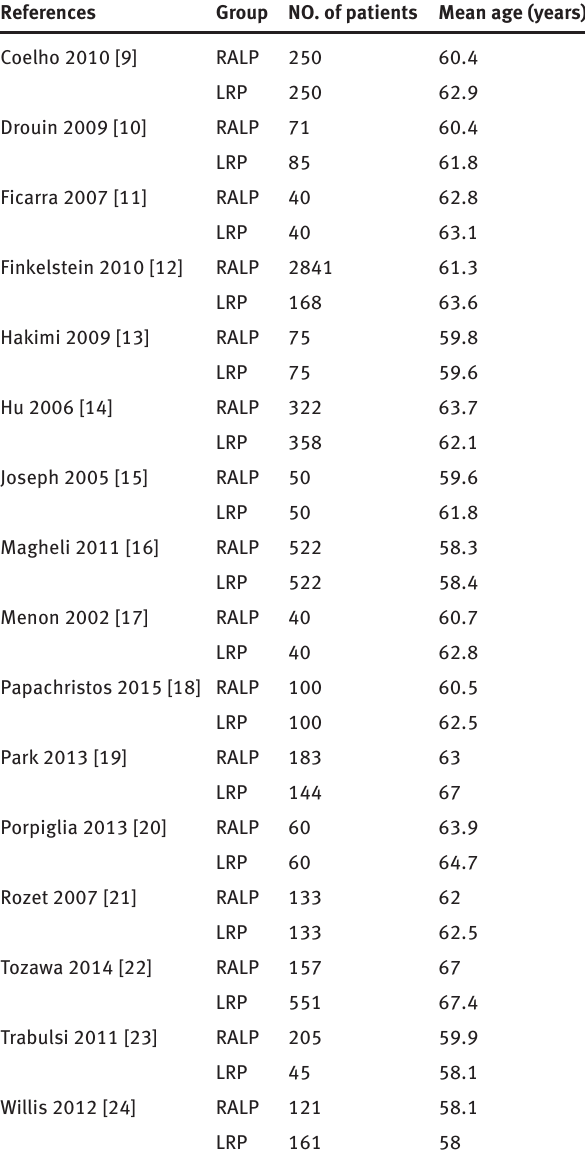
Table 1: Baseline characteristics of included